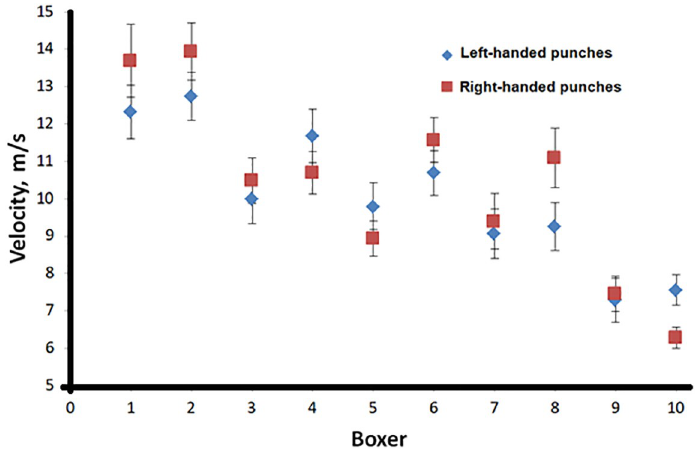
Fig 6. The effectiveness of 10 boxers’ punches made with the left (rhombus) and right (square) hands.